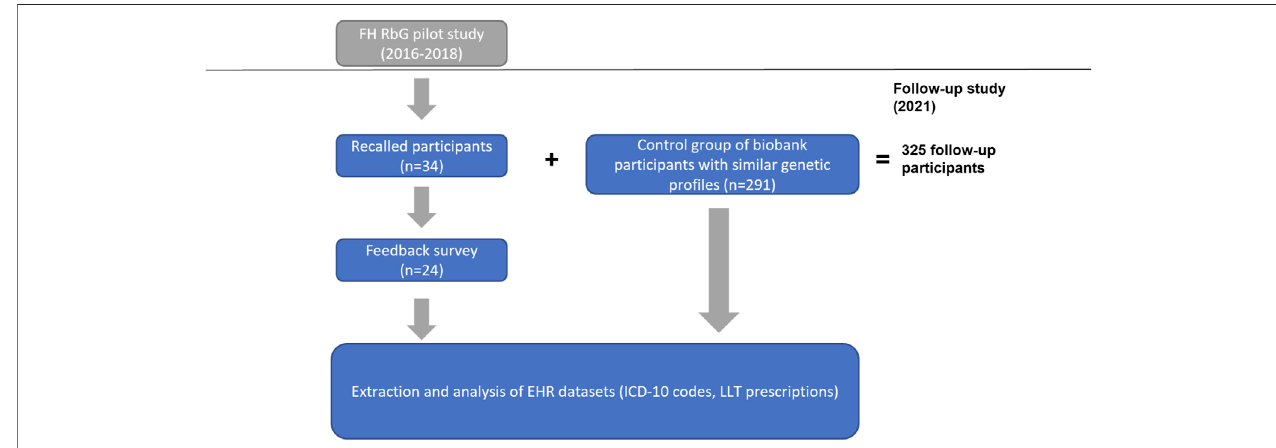
FIGURE 1 | The work fl ow of the study. The initial cohort of recalled participants originated from the FH RbG pilot study conducted by Alver et al. in 2016 – 2018. Recalled participants who had also signed up as biobank participants by Fall 2021 were eligible to participate in the